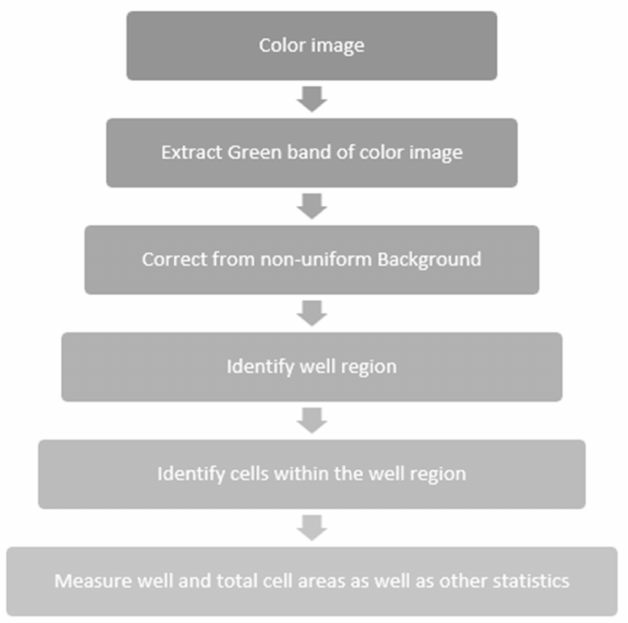
Figure 5. Processing